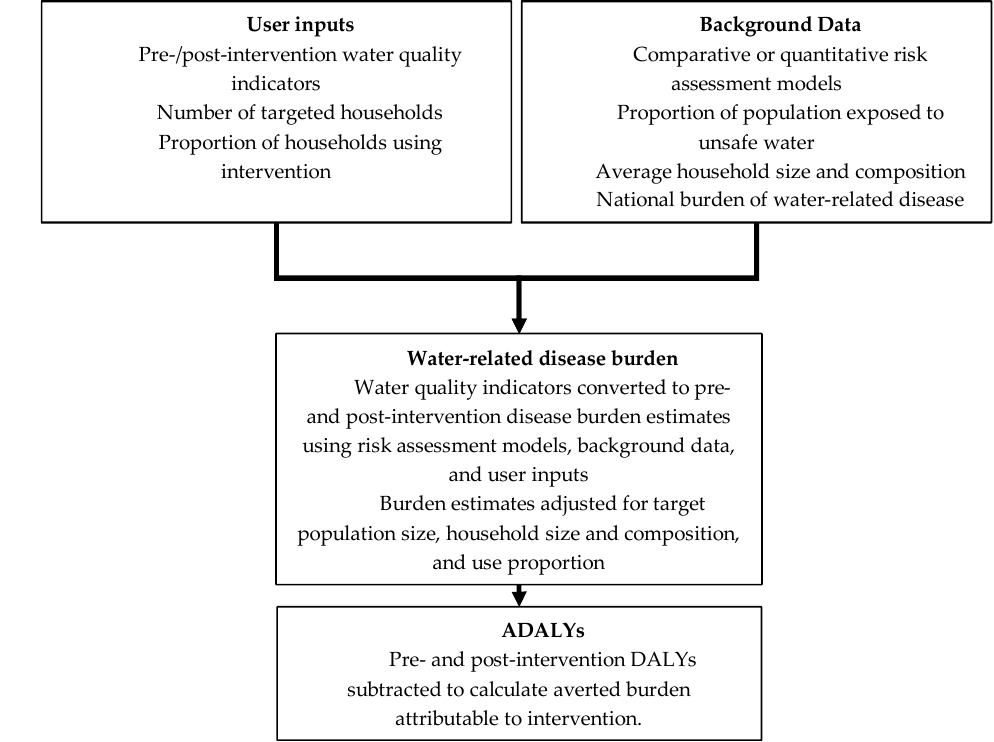
Figure 1. Schematic illustrating the process of estimating ADALYs using user-supplied and background data. background